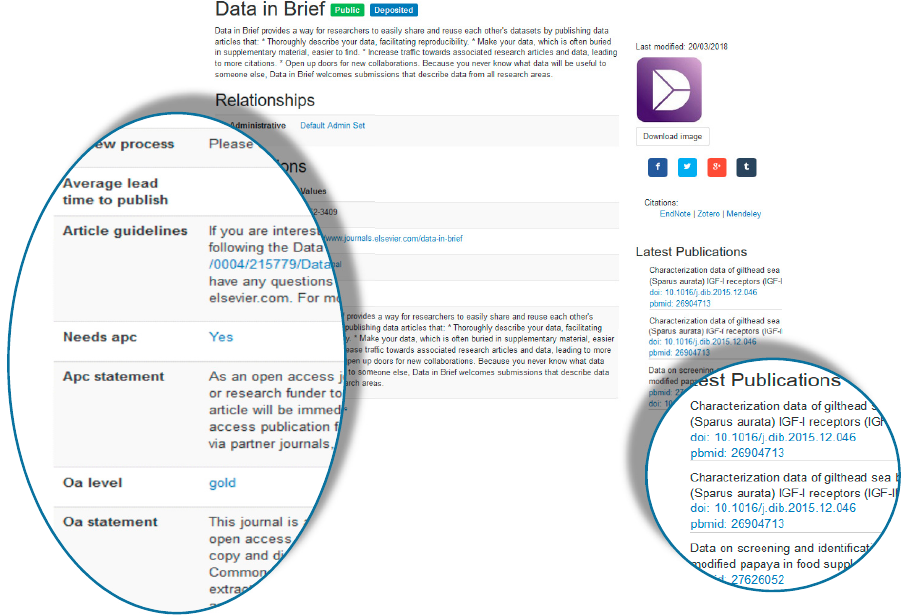
Figure 4. Journal Details in Data2paper: highlighting APC details and also recent publications (via SCHOLIX) .